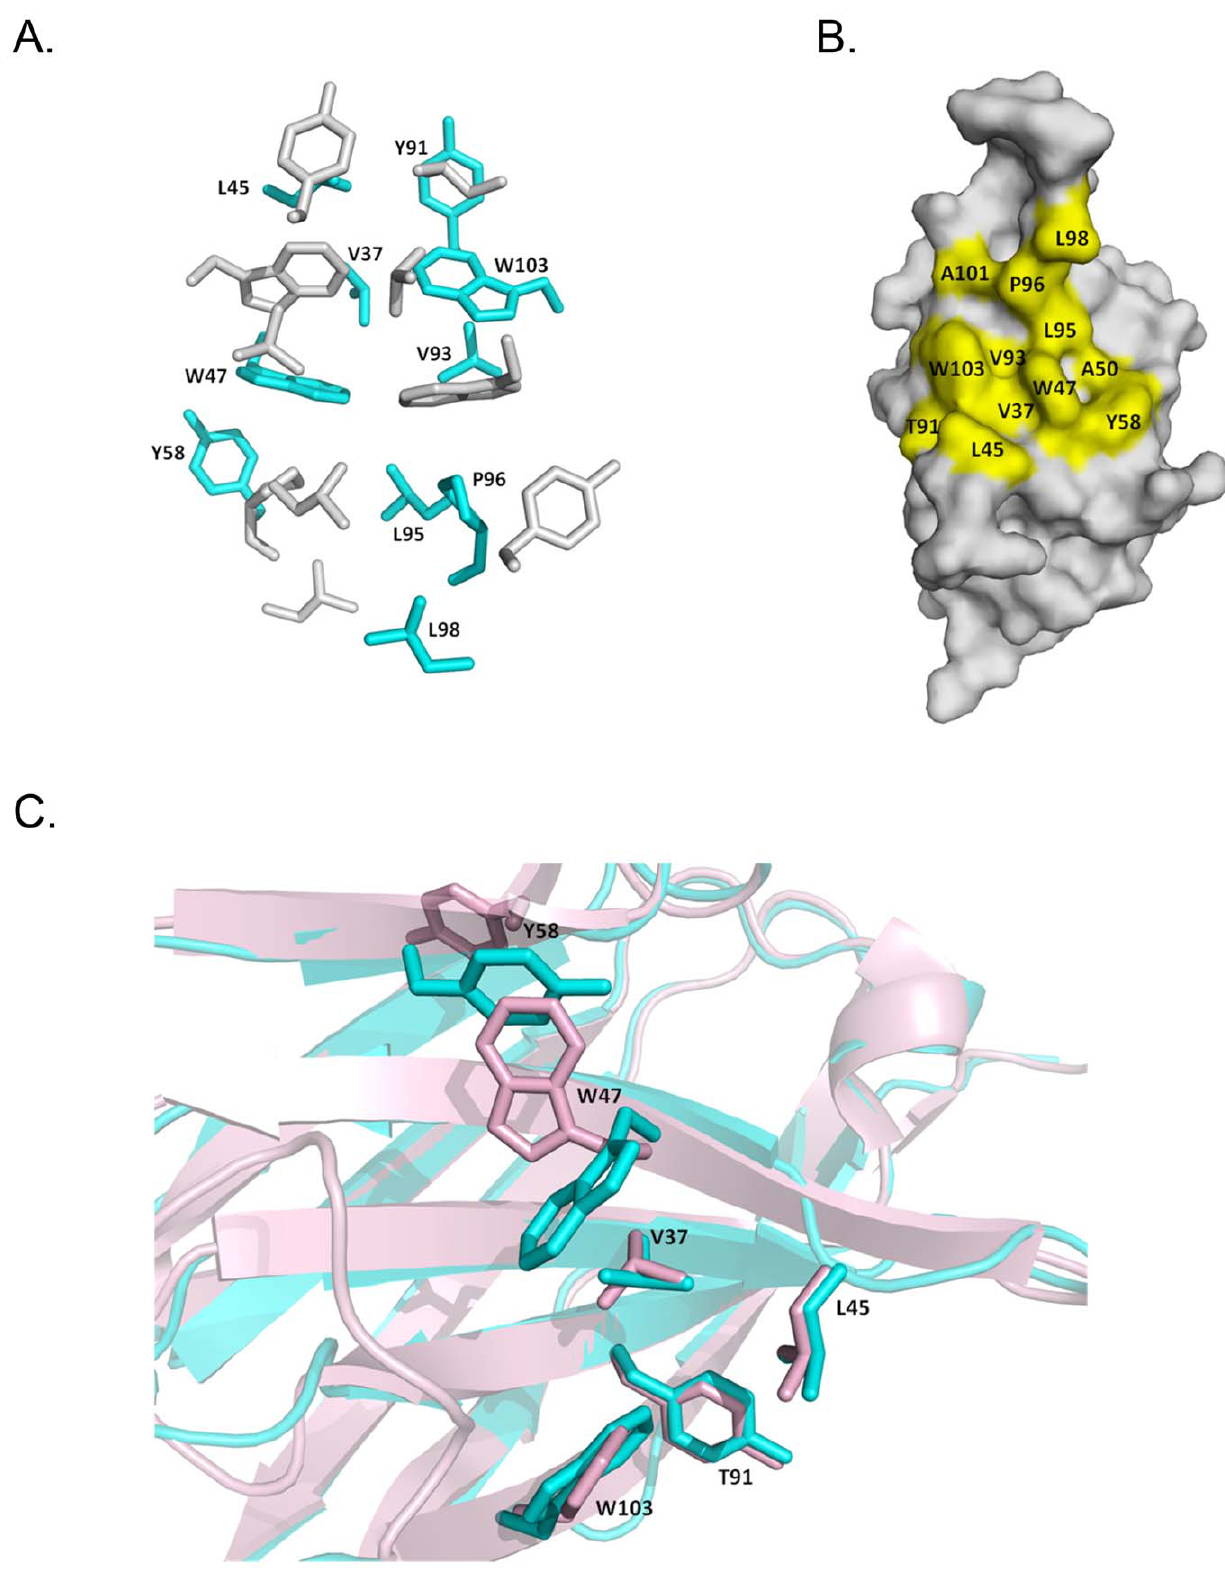
Figure 4. Hydrophobic interface of Gr6 dimer. ( A ) View of side chain arrangement at the V H -V H hydrophobic interface of Gr6 homodimer. One Gr6 monomer is shown in cyan and the other one is shown in gray. ( B ) Surface representation of V H . Residues involved in dimer formation are highlighted in yellow. ( C ) Superposition of residues at V H -V H interface of Gr6 with that at V H -V L interface of Fv-POT to show the structural resemblances of the residues that are located at framework-2 involved in the dimer formation. doi:10.1371/journal.pone.0030149.g004 PLoS ONE |